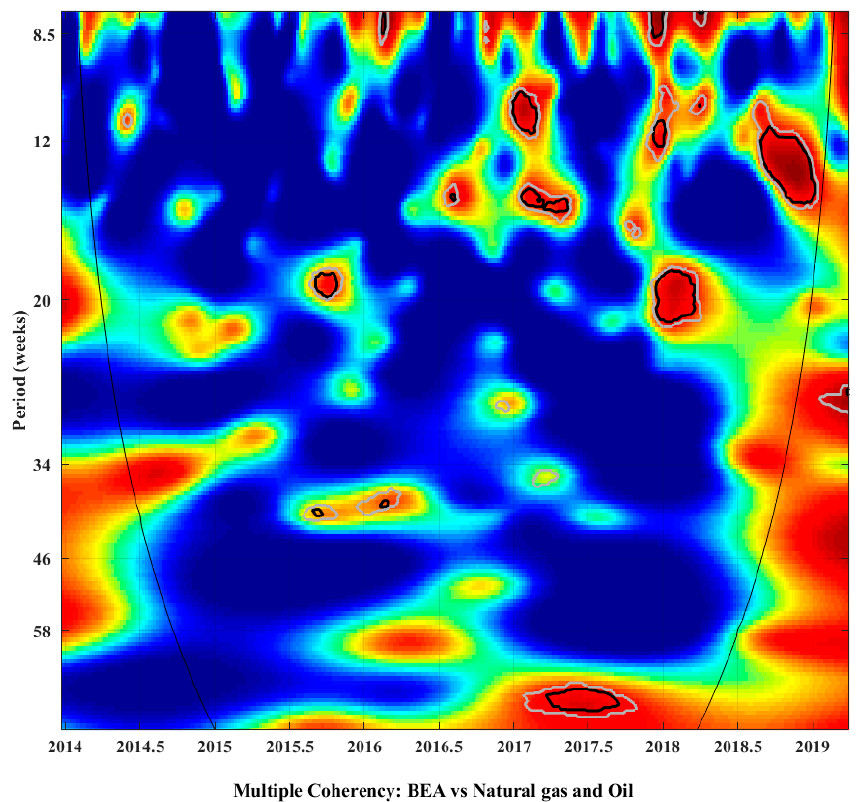
Figure 2. Multiple-wavelet power spectrum between Beijing carbon price and energy (natural gas and oil) prices.